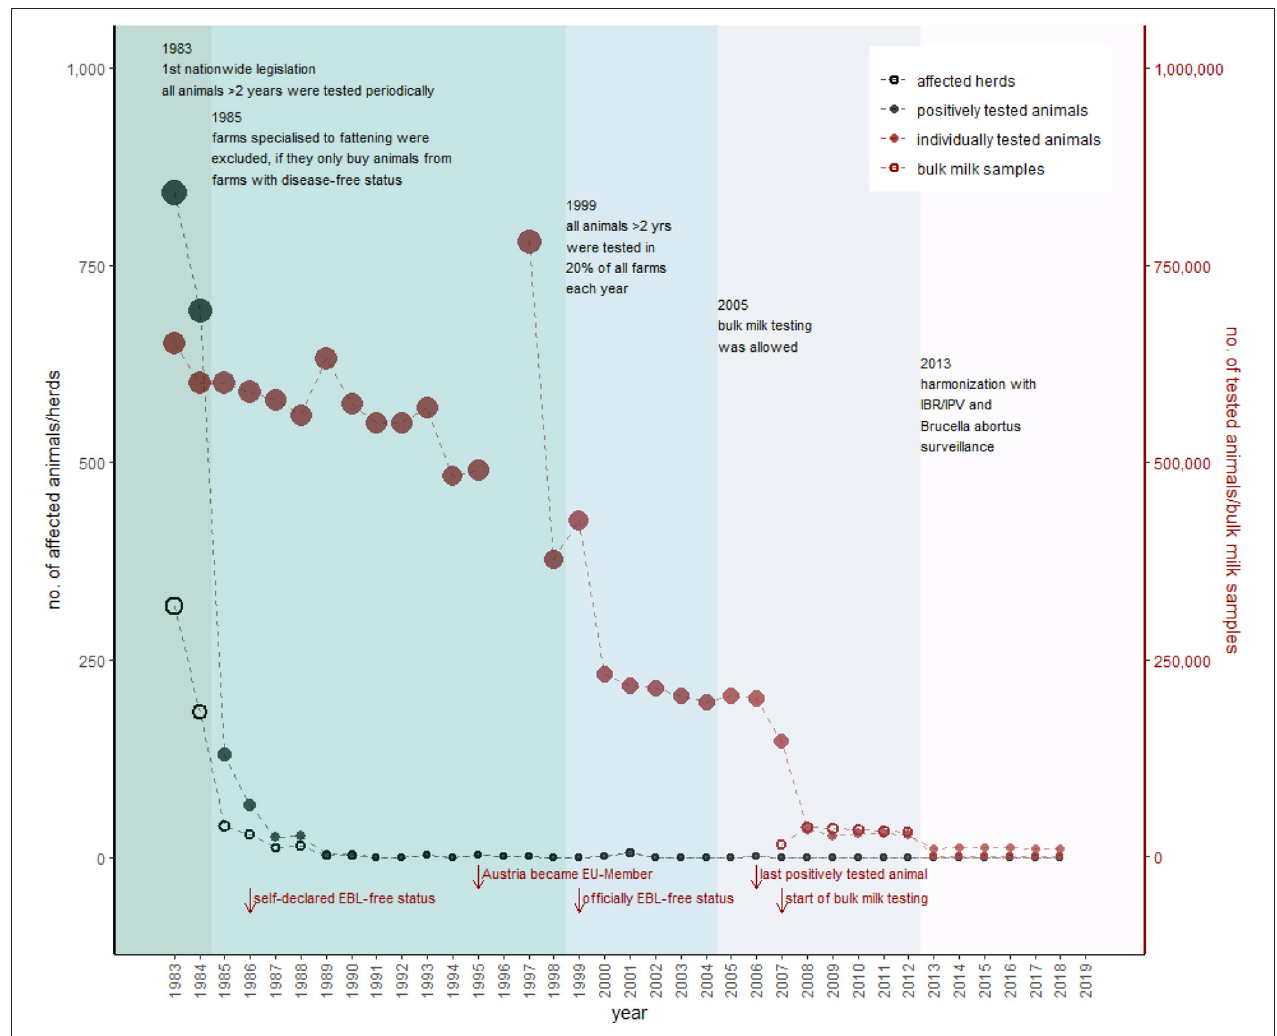
FIGURE 3 | Overview of the historical development of EBL control in Austria. Black dots represent the number of positively tested animals (filled) and number of herds with at least one positively tested animal (empty), according to the primary y -axis. The red dots show the number of individually tested animals (filled) and number of herds tested via bulk milk (empty), according to the secondary y -axis (detailed data are provided in Supplementary Table 1 ). The most important changes in legislation with consequences for the sampling strategy represent the different colors within the figure. Red arrows show further essential events regarding EBL in